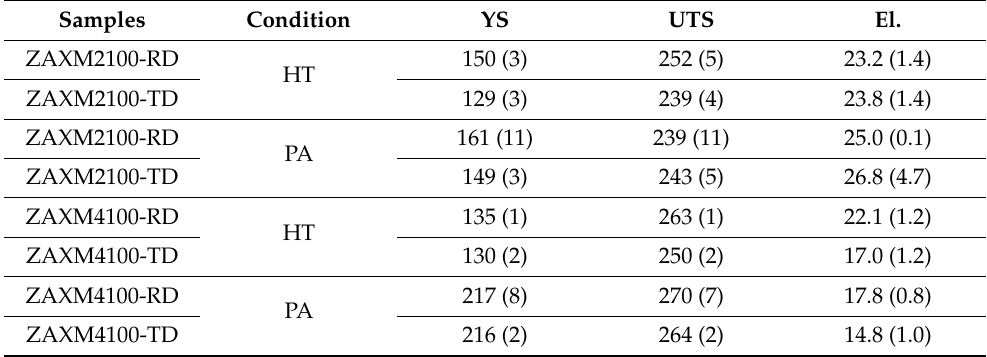
Figure 11. Tensile properties of homogenized and peak-aged ( a ) ZAXM2100 and ( b ) ZAXM4100 alloy sheets along RD and TD. Table 3. Tensile properties of homogenized (HT) and peak-aged (PA) ZAXM2100 and ZAXM4100 alloy sheets along RD and TD. The numbers in parentheses indicate standard deviations of the